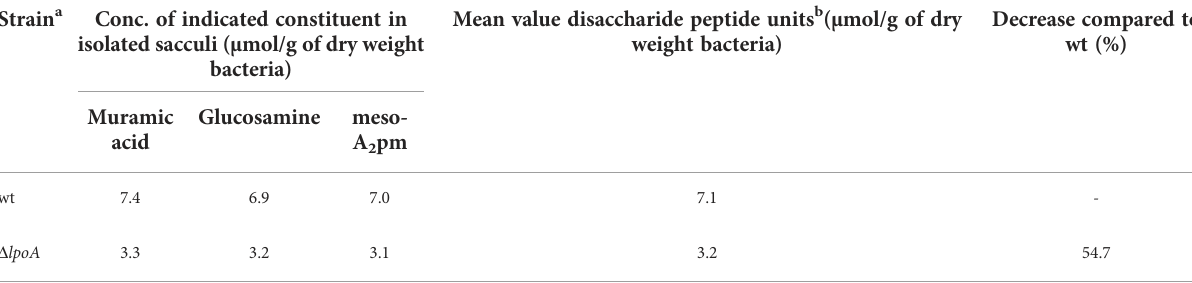
TABLE 1 Peptidoglycan content of H. in fl uenzae 3655 wt and isogenic D lpoA in early exponential phase. Strain